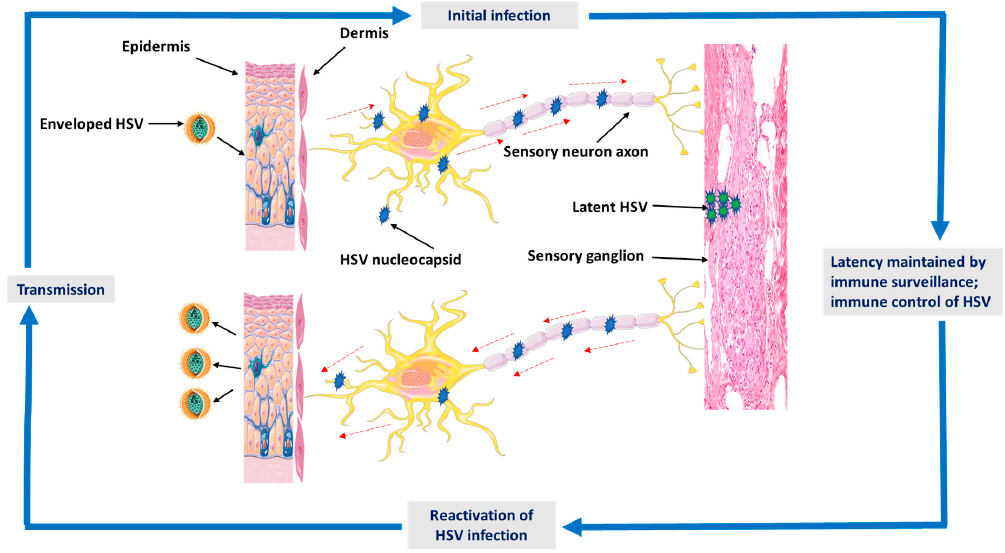
Figure 1. A graphical illustration shows the epidemiology and pathogenesis of herpes simplex virus (HSV) infection. Detailed descriptions are discussed in Section